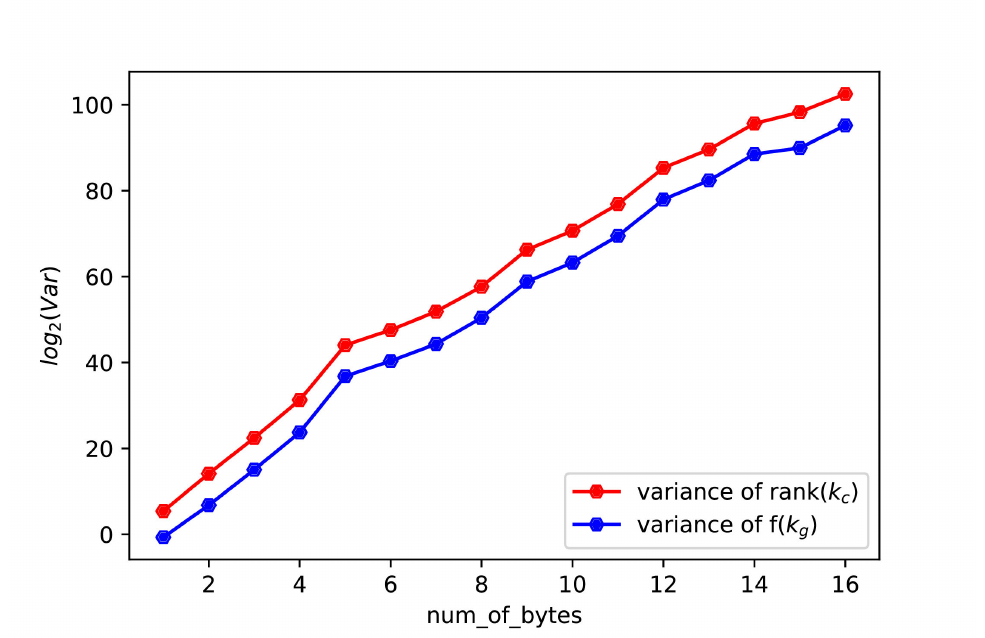
Figure 3: Comparison between variance of rank ( k c ) and variance of f ( k g